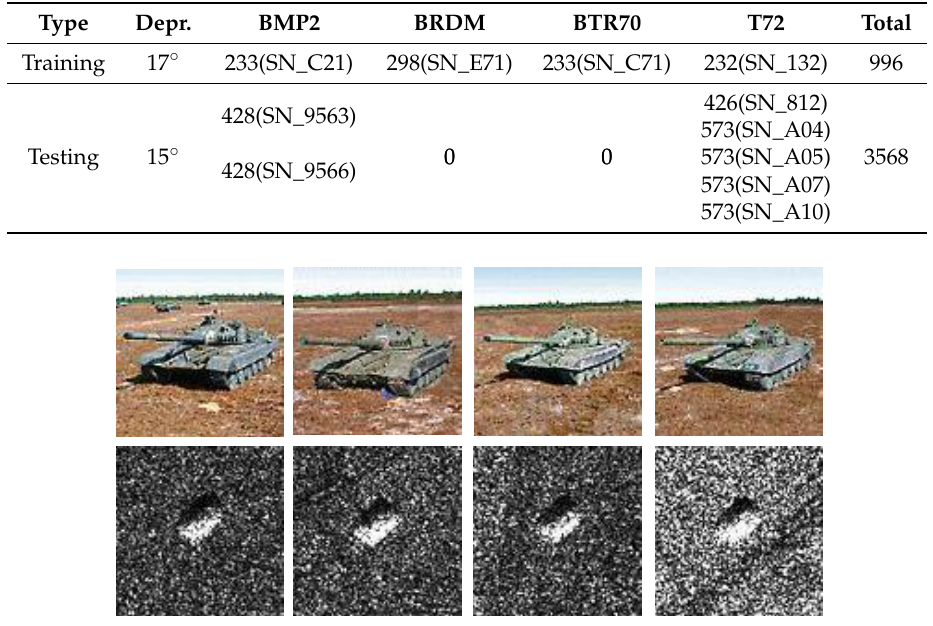
Figure 5. Examples of T72 with different configuration variations; the optical and SAR images listed from left to right are A04, A05, A07 and A10. Table 8. The recognition performances of different methods under configuration variance